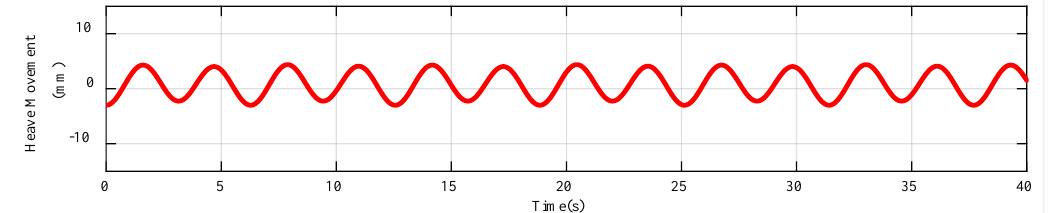
Figure 29. Heave movement of the R-deck of the compensation platform. The final movement range is less than 1 cm.